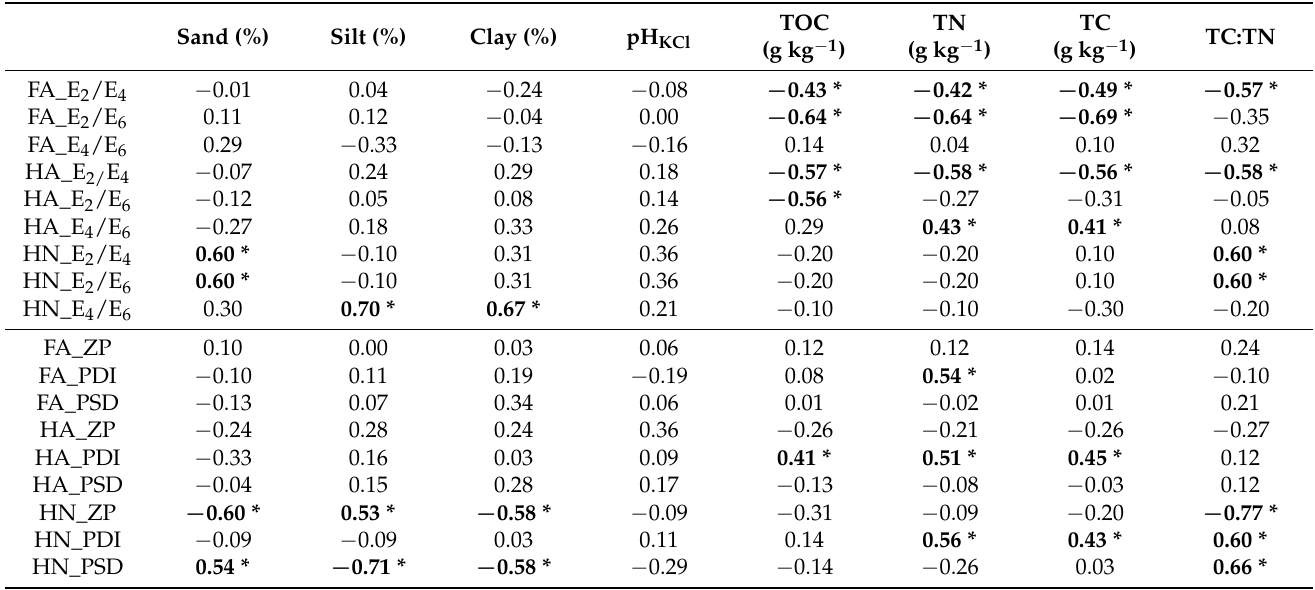
Table 5. Relations between basic soil physico-chemical properties and HS parameters calculated based on the Spear- man’s